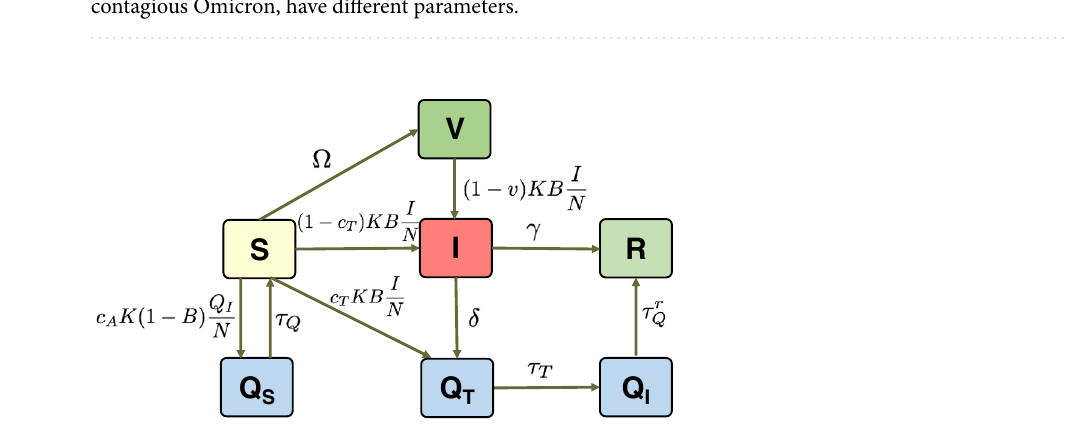
Table 2. Some estimated parameters for the initial variants (year 2020) of COVID-19 2,3,27,36 . The time unit is days. The column value shows the values used in our experiments. Note that some of these parameters can vary depending on the country and age group, as shown in the column range . Later variants, such as the extremely contagious Omicron, have different parameters.